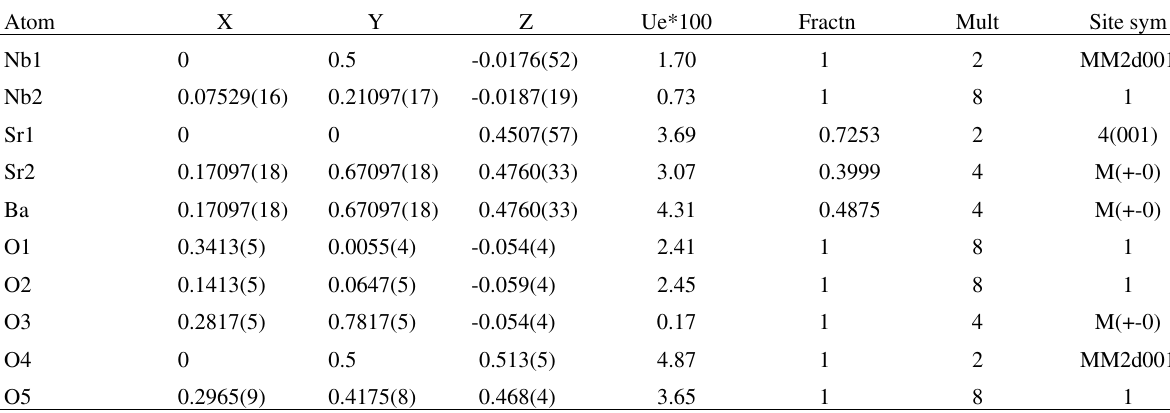
Table 2. Refinement results for SBN ceramic.